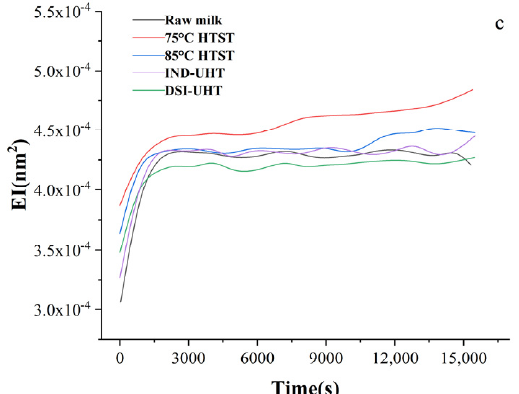
Figure 3. Microrheological test of the milk using a microrheolaser. Typical examples of the MSD vs. the time curves of the raw milk ( a1 ), 75 ◦ C HTST ( a2 ), 85 ◦ C HTST ( a3 ), IND-UHT ( a4 ), and DSI-IUHT ( a5 ). The arrow represents the direction of the curve. The influence of different heat treatment methods on the MVI ( b ) and EI ( c ).